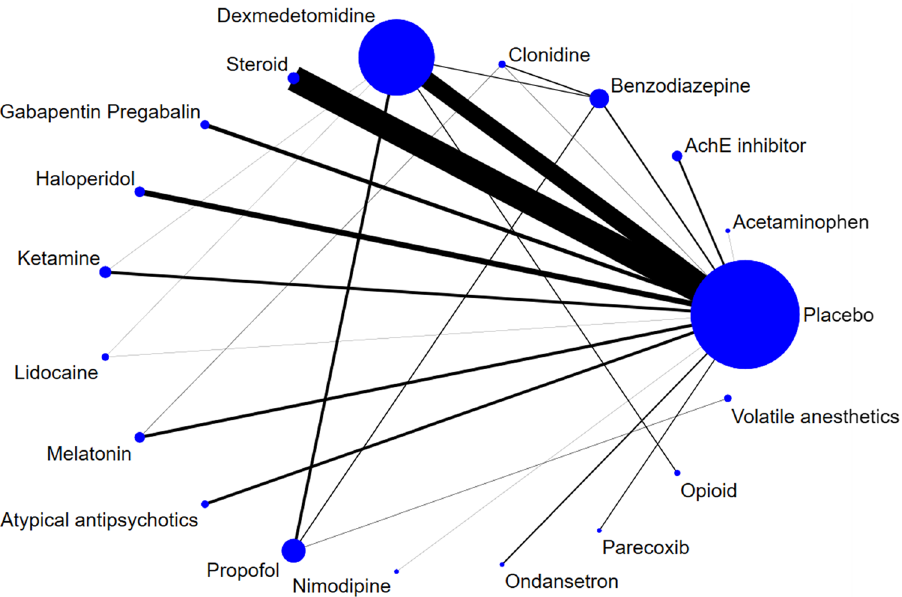
Figure 2. Network plot of our network of postoperative delirium. Nodes are weighted according to the number of patients with the respective interventions. Edges are weighted according to the number of patients included the comparison between the two connected modalities. No connection between any pair of the comparison means the comparison was made from the indirect